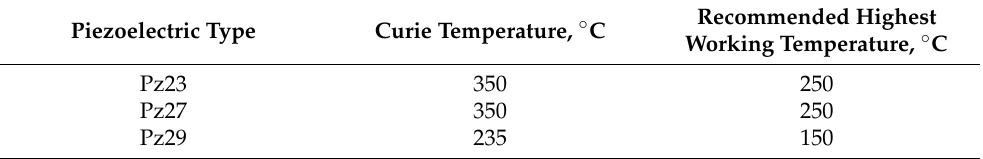
Table 4. Temperature properties of PZT type piezoelectric